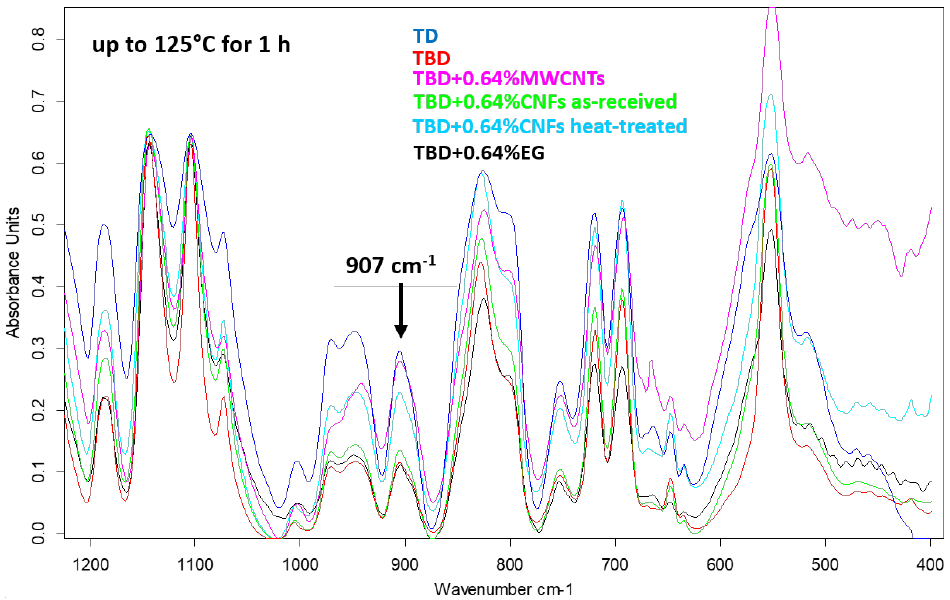
Figure 3. FTIR spectra of neat and nanocomposite systems cured up to 180°C for 3 h.